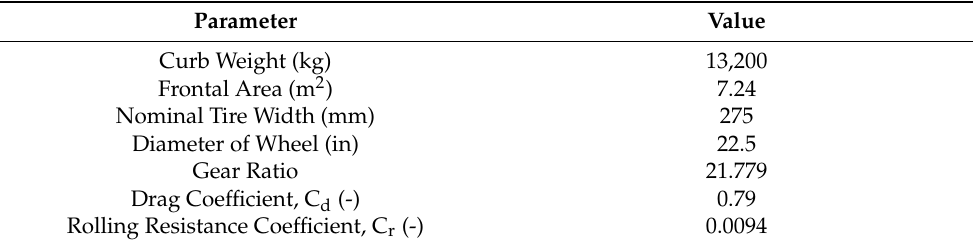
Table 2. Vehicle